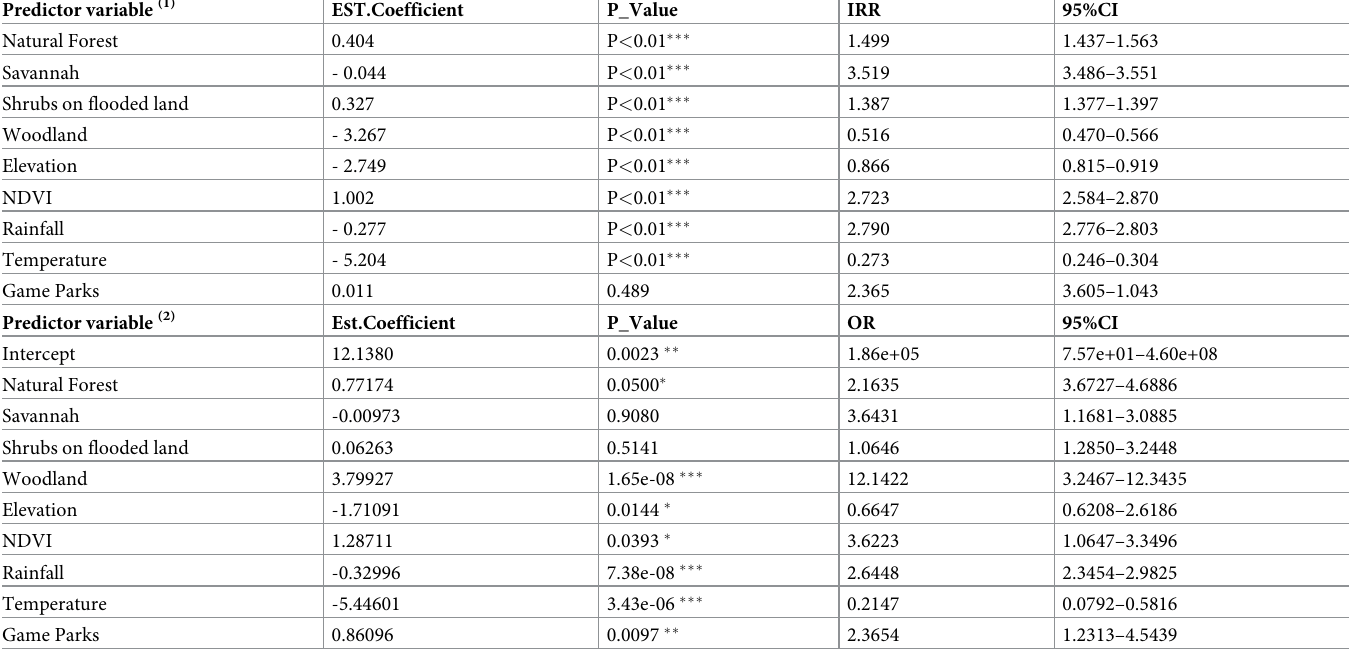
Table 3. Zero-Inflated Poisson regression results for estimation of tsetse abundance based on climatic and environmental factors. Below are two blocks (regimes); one is a block of output containing Poisson regression coefficients for each of the variables along with p -values, incident risk ratios and confidence intervals for the coeffi- cients. The second block includes logit coefficients for predicting excess zeros along with their Odds Ratios (OR), confidence intervals and p